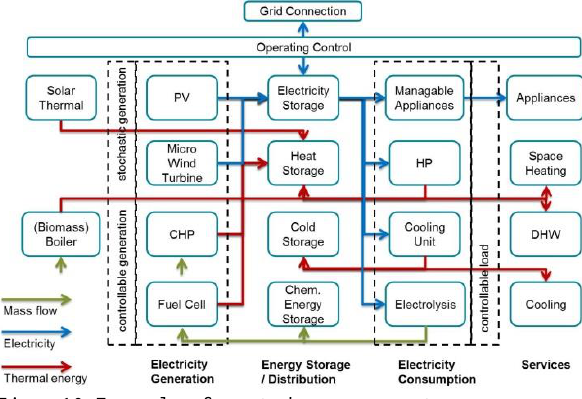
Figure 10: Examples of smart urban energy systems Linking a dynamic system (e.g. ABM) and 3D city models,